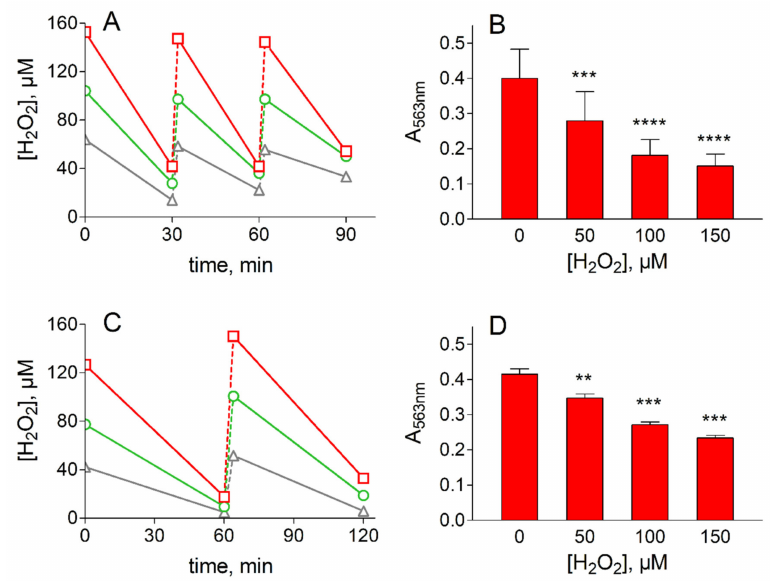
Figure 4. Treatment of lens epithelial cells with H 2 O 2 . ( A ) and ( B ) refer to H 2 O 2 removal and viability assay in HLEC, respectively. ( C ) and ( D ) refer to H 2 O 2 removal and viability assay in bovine lens epithelial cells (BLEC), respectively. Panel ( A ): HLEC at 70% confluence (2.5 × 10 6 cells) were incubated in Minimum Essential Medium (7 mL) at 37 ◦ C; at the indicated times cells were supplemented with 50 (gray), 100 (green) or 150 (red) µ M H 2 O 2 and the concentration of the peroxide was measured as described in Section 2.4. C : BLEC at 70% confluence (1.0 × 10 6 cells) were incubated in HBSS (7 mL) at 37 ◦ C; at the indicated times, cells were supplemented with 50 (gray), 100 (green) or 150 (red) µ M H 2 O 2 and the concentration of the peroxide was measured as described in Section 2.4. ( C ) and ( D ): Cell viability was evaluated by MTT assay (see Section 2.3) at the end of overall oxidative treatment at the indicated concentrations of H 2 O 2 . The values represent the mean ± SEM of at least three independent experiments. Significance was evaluated with respect to untreated cells (** p < 0.01, *** p < 0.001, **** p <